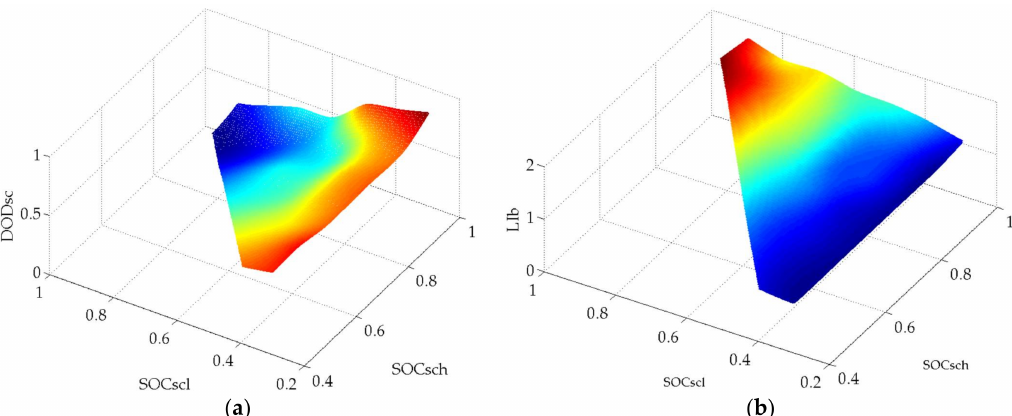
Figure 12. Three-dimensional diagrams of battery loss index and supercapacitor’s maximum depth of discharge (DOD). ( a ) Maximum DOD of the supercapacitor. ( b ) Battery loss index.